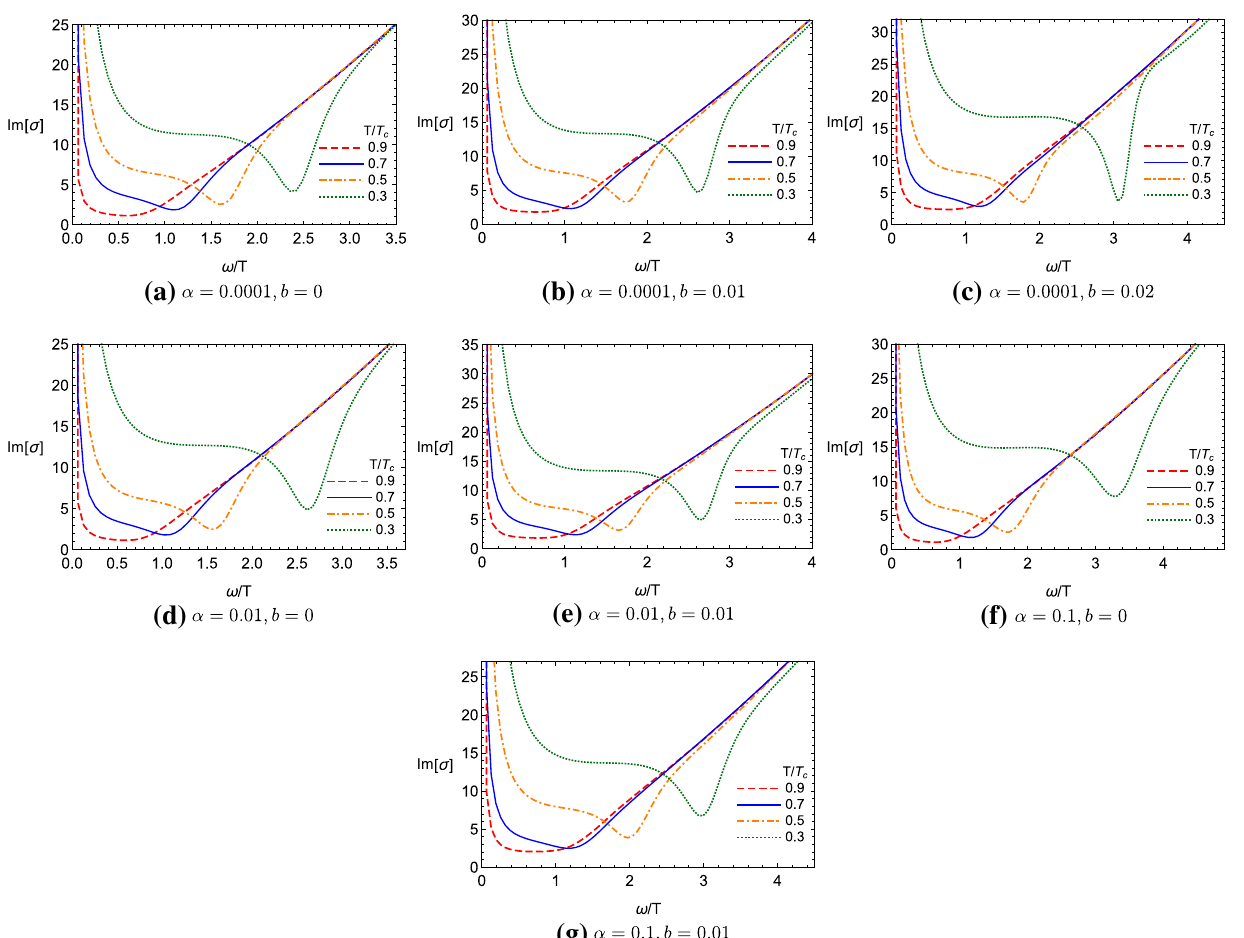
Fig. 5 The imaginary part of the conductivity as a function of frequency for different values of b and α . Each figure is plotted for different temperatures T / T